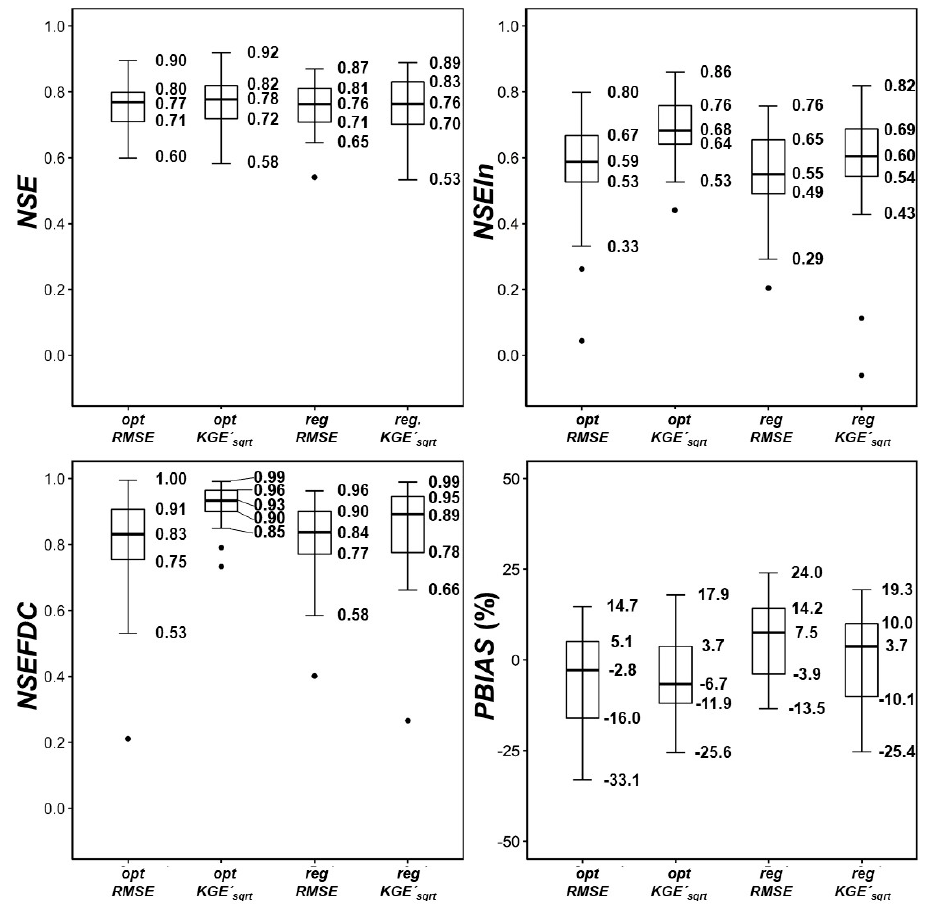
Figure 6. Comparison of performance statistics ( NSE , NSEln , NSEFDC , and PBIAS ) provided by the calibrated ( optRMSE and optKGE (cid:48) sqrt ) and regionalized models ( regRMSE and regKGE (cid:48) sqrt ) for the 39 study watersheds used for regionalization.